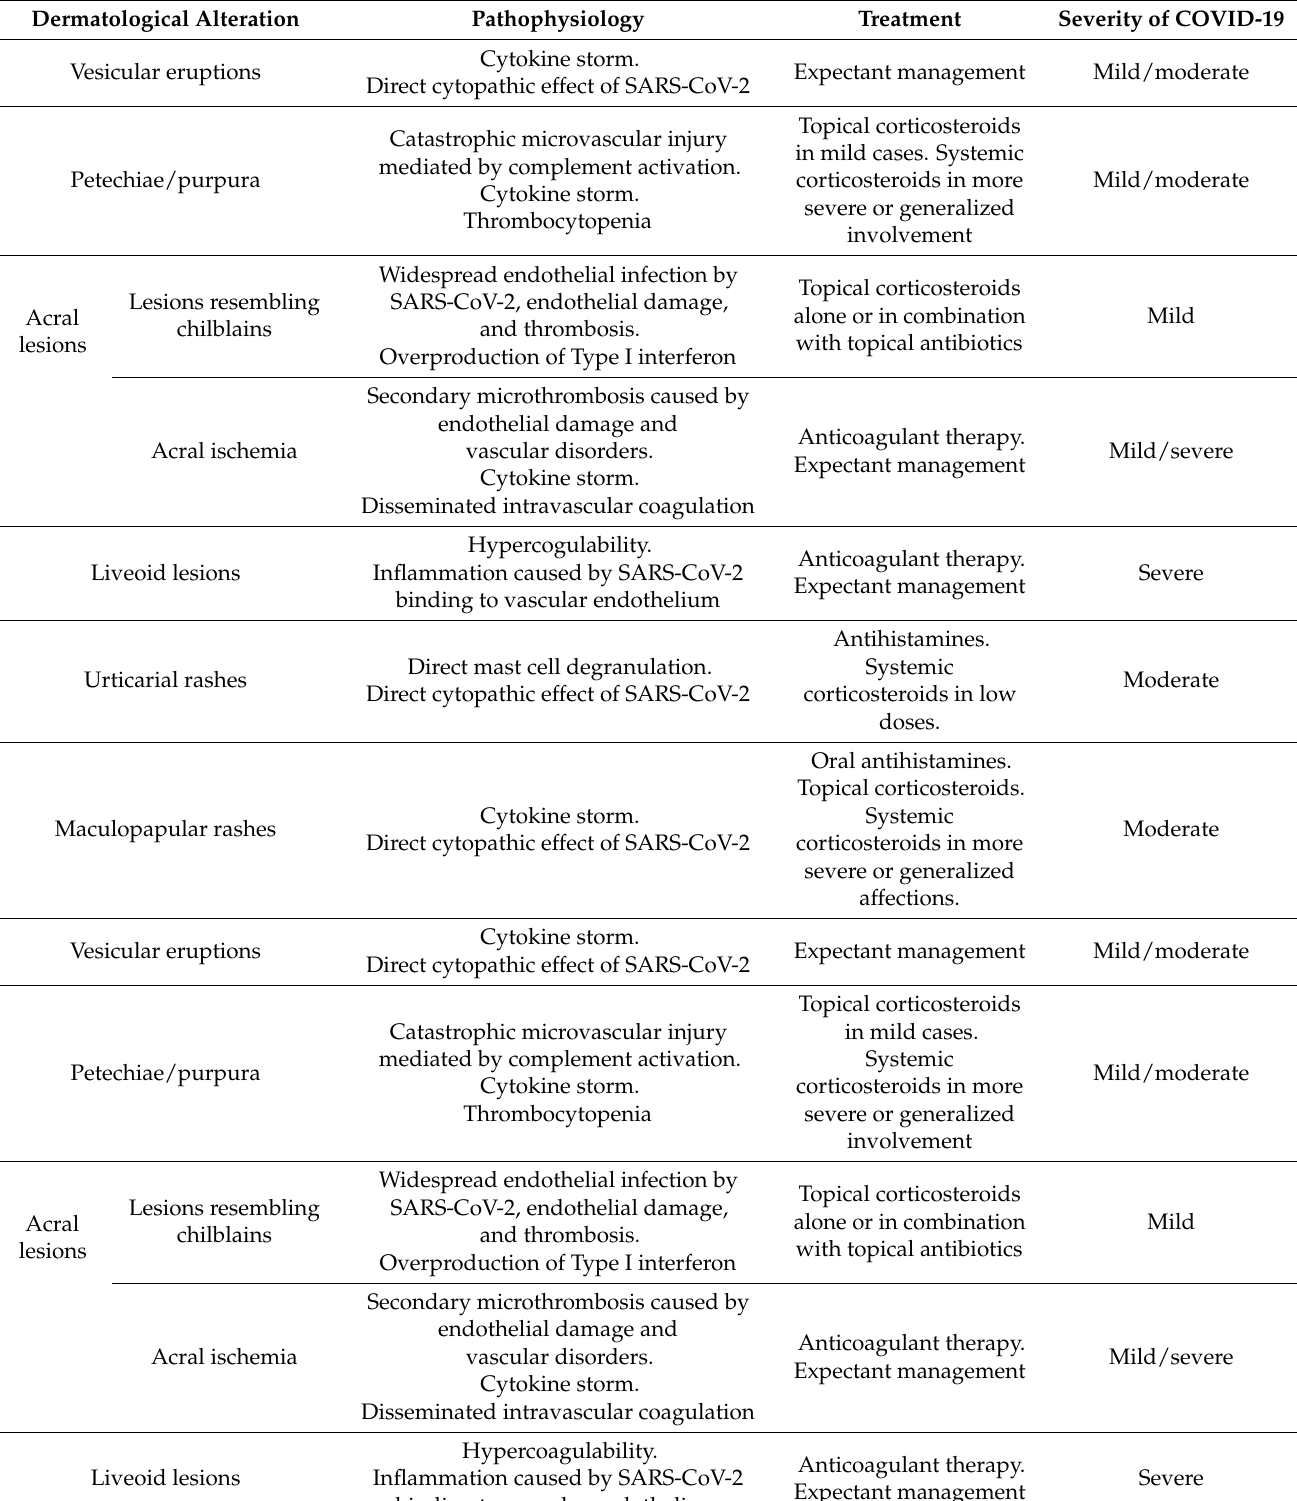
Table 2. Triggering mechanism and treatment of the most common dermatological alterations by SARS-CoV-2. Dermatological